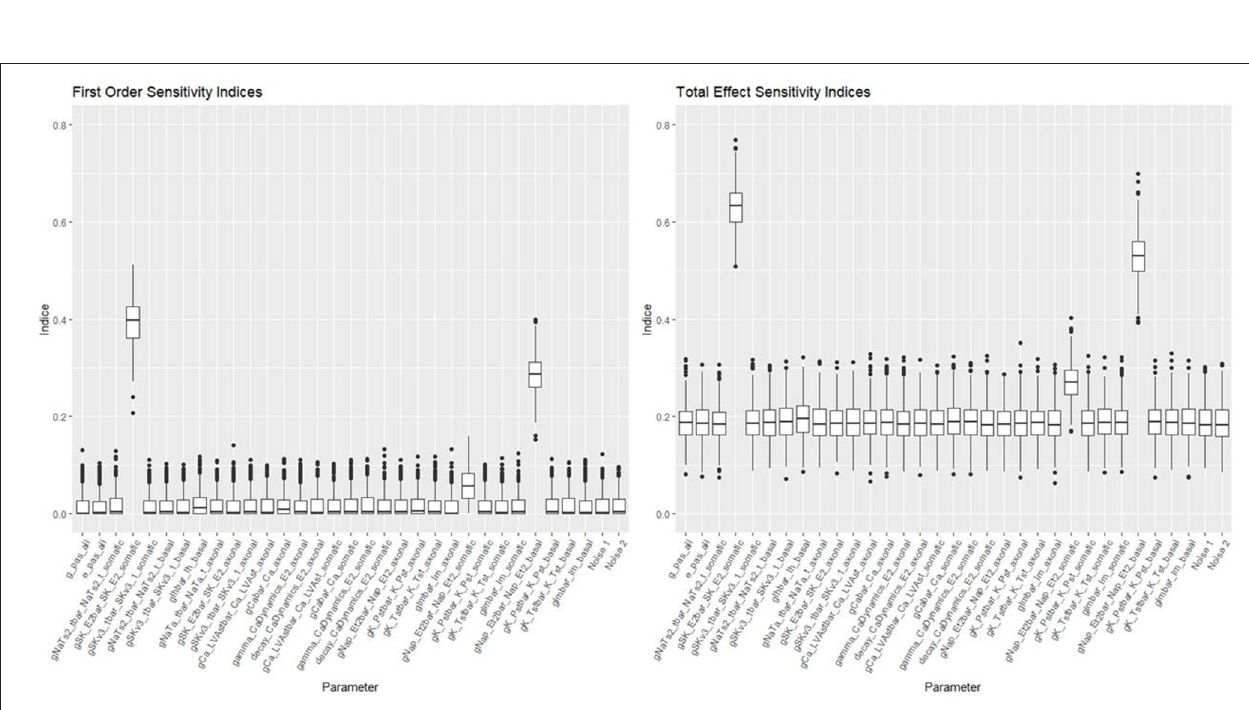
FIGURE 11 | Sensitivity indices for each input factor in emulating minimum voltage between spikes. The panel on the left shows first-order indices, and the panel on the right show total effect indices. The last two factors on the right are randomly added “noise factors,” which indicate what might be expected for a factor that, by design, has no impact at all on the